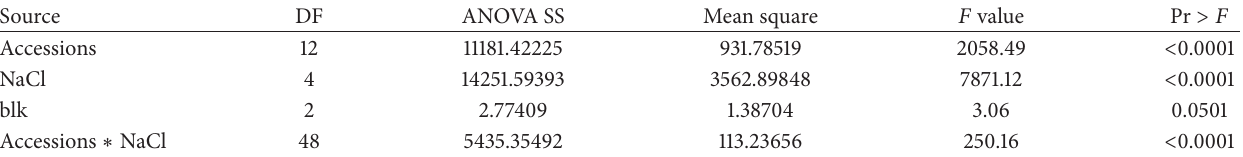
Table 7: ANOVA table for number of flowers with salinity treatments.